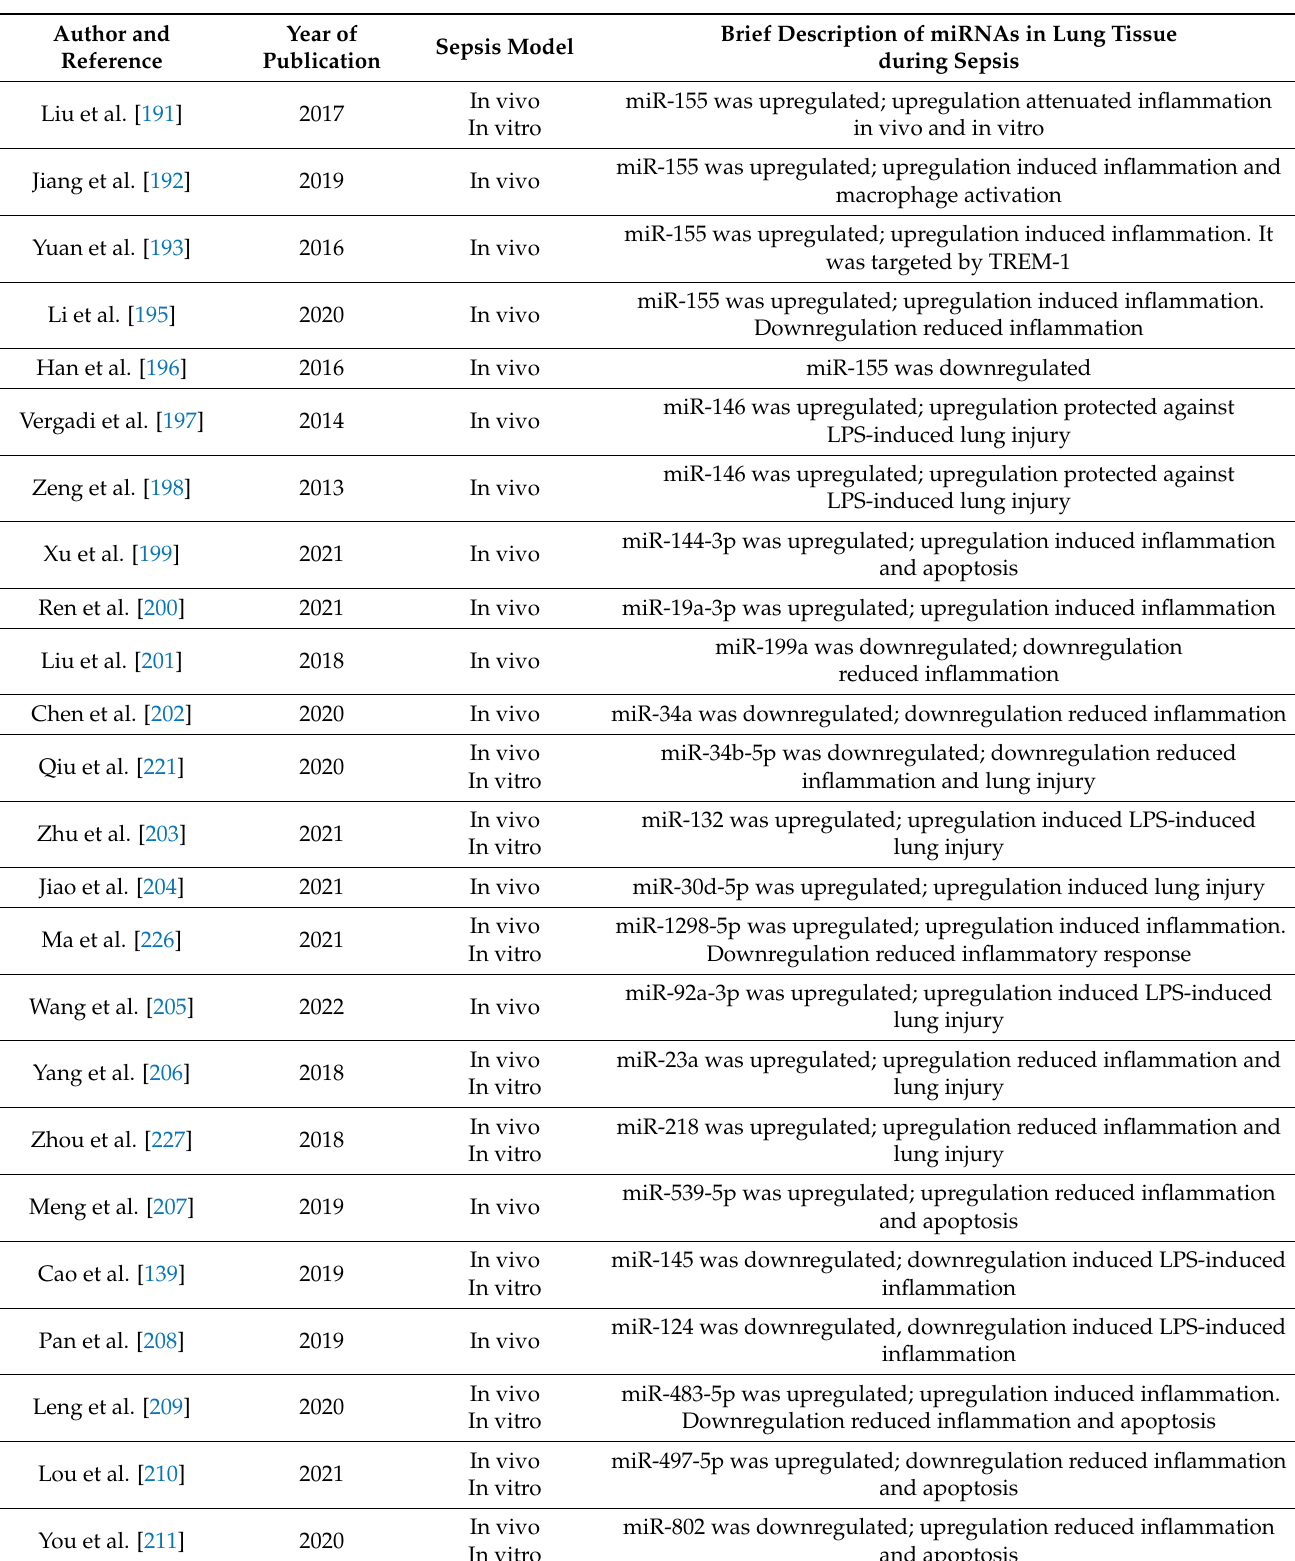
Table 4. miRNA expression in sepsis-related lung